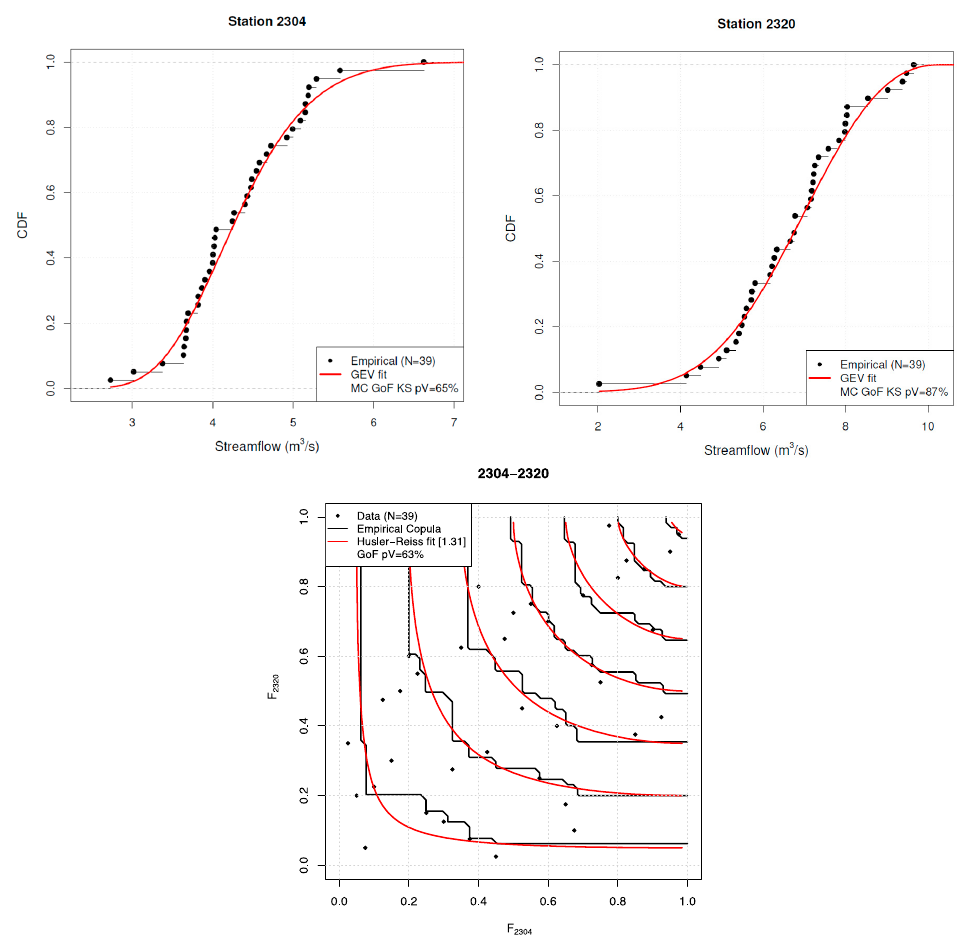
Figure 5. Upper Çoruh basin. ( Top row ) Generalized extreme value (GEV) fits of the 7-day low flow series in the upper Çoruh basin. Shown: the empirical CDF (black markers), the fitted CDF (red line), the sample size N and an approximate Monte Carlo Goodness-of-Fit test p -value of Kolmogorov–Smirnov type. ( Bottom row ) Copula fit. Shown: the pseudo-observations (markers), the empirical copula (black lines) and the fitted copula family (red lines). Additionally shown are the sample size N, an MLE estimate of the copula parameter, and an approximate Monte Carlo Goodness-of-Fit test p -value of Cram é r-von Mises